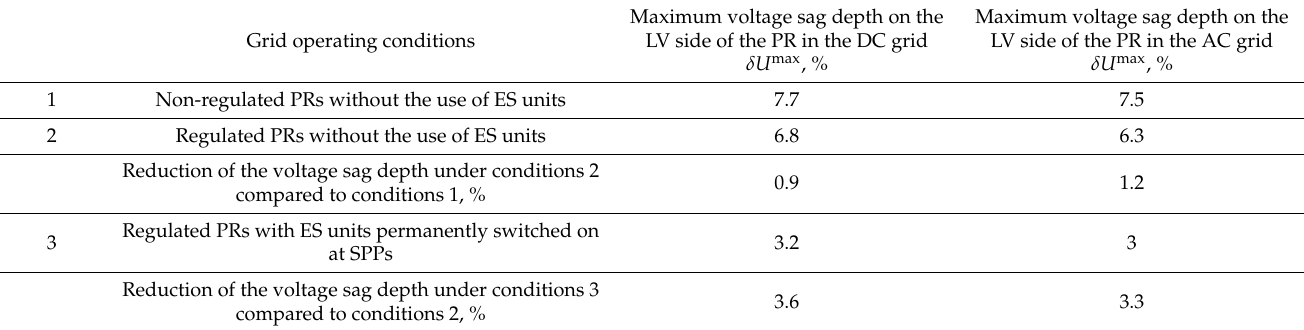
Table 2. Voltage sag simulation results with a heavy load connected .